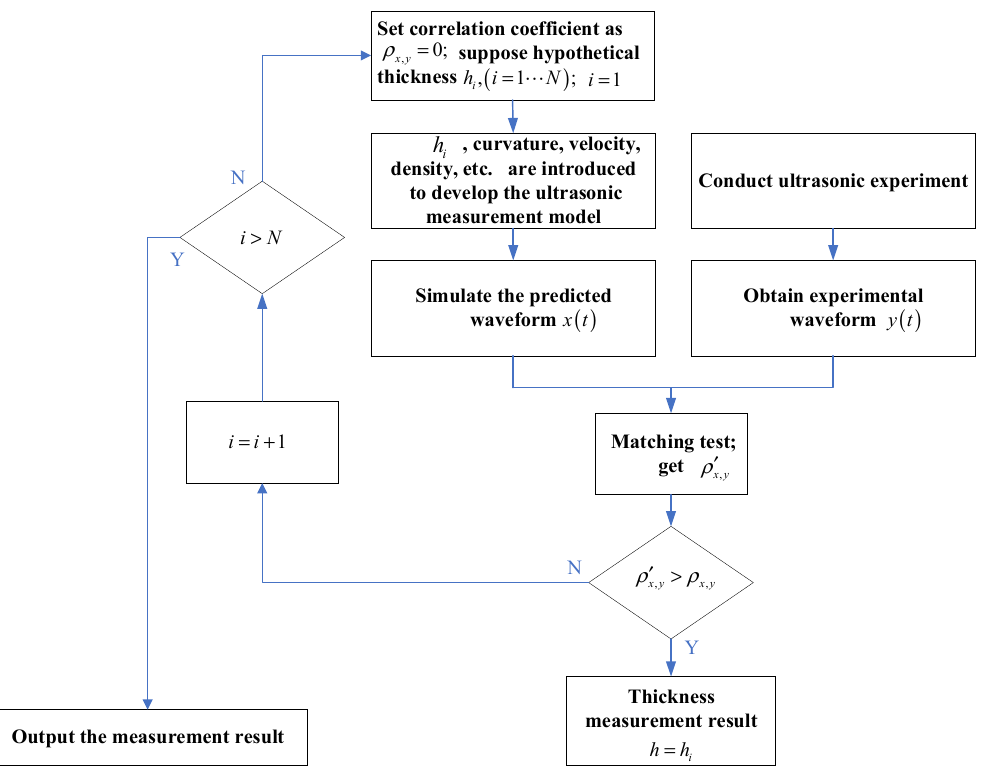
Figure 1. The overall flow chart of the thickness measurement.